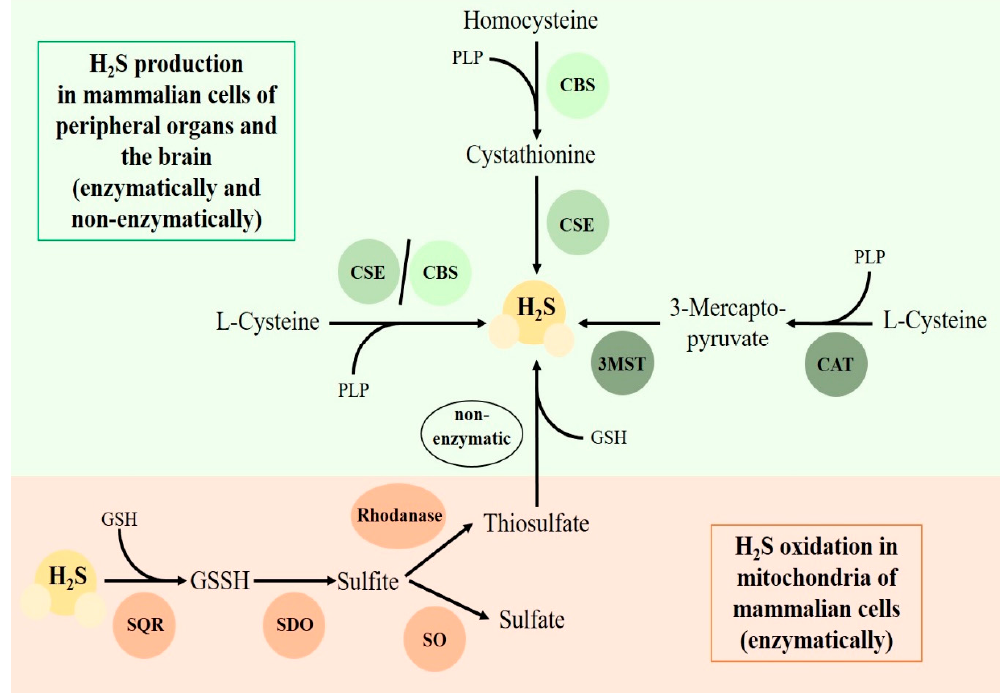
Figure 1. H 2 S biosynthesis and oxidation pathways. H 2 S can be produced in the vasculature, heart, brain, placenta, colonic tissue, liver, kidney and other mammalian tissues [8]. L-cysteine and homocysteine are the essential substrates for enzymatic endogenous H 2 S production by CSE, CBS or 3MST. L-Cysteine can be directly used as a substrate for H 2 S generation via the enzymes CSE or CBS. Homocysteine is converted to cystathionine by CBS and then converted to H 2 S by CSE. Cysteine-aminotransferase (CAT) can metabolize L-cysteine to 3-mercaptopyruvate, which is then converted to H 2 S by 3MST. CSE, CBS and CAT require the cofactor pyridoxal 5 ′ -phosphate (PLP) [8]. Non-enzymatic H 2 S generation can take place during hypoxic events, for example, via thiosulfate utilization. Thiosulfate is an oxidation product of H 2 S, which is part of the stepwise enzymatic sulfide oxidation pathway within the mitochondria and can be reduced, e.g., with glutathione (GSH), to H 2 S [8,9]. Sulfide quinone oxidoreductase (SQR) oxidizes H 2 S to glutathione persulfide (GSSH); that is followed by oxidation of GSSH to sulfite by persulfide dioxygenase (SDO); and finally, sulfite is oxidized to either sulfate by sulfite oxidase (SO) or to thiosulfate by rhodanese. There is a dearth of information regarding the direct interaction between the H 2 S and OT